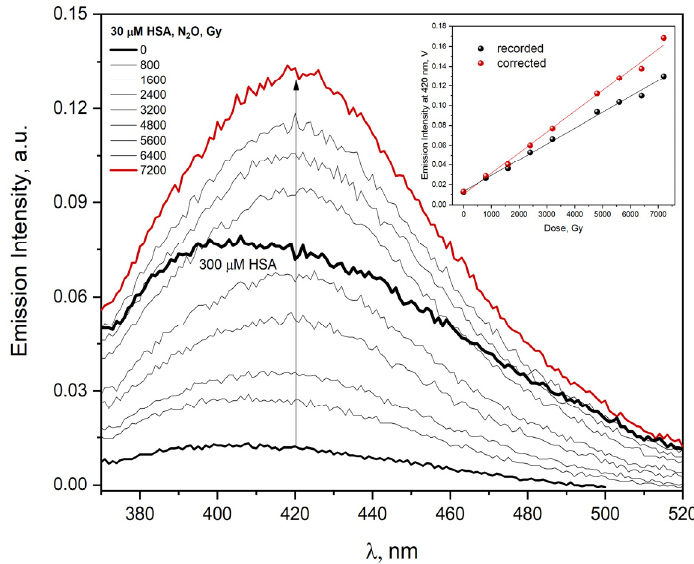
Figure 14. Emission spectra of N 2 O-saturated buffer solution of HSA (30 µM), obtained for irradiation doses between 0 and 7200 Gy. Emission spectrum of neat HSA solution (300 µM). The excitation wavelength was 320 nm. The arrow presented in the figure shows the increase in the intensity of the emission signal as a function of the absorbed dose. Insert : Dependence of I max as a function of dose (0–7200 Gy) before and after inner filter effect correction.